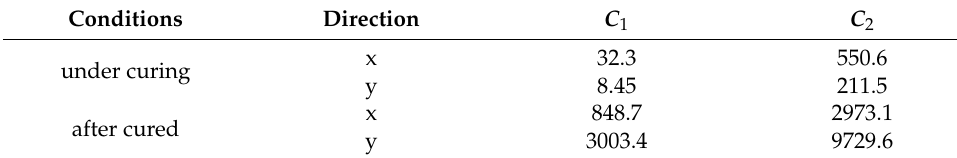
Table 3. Material constants of WLF shift function.